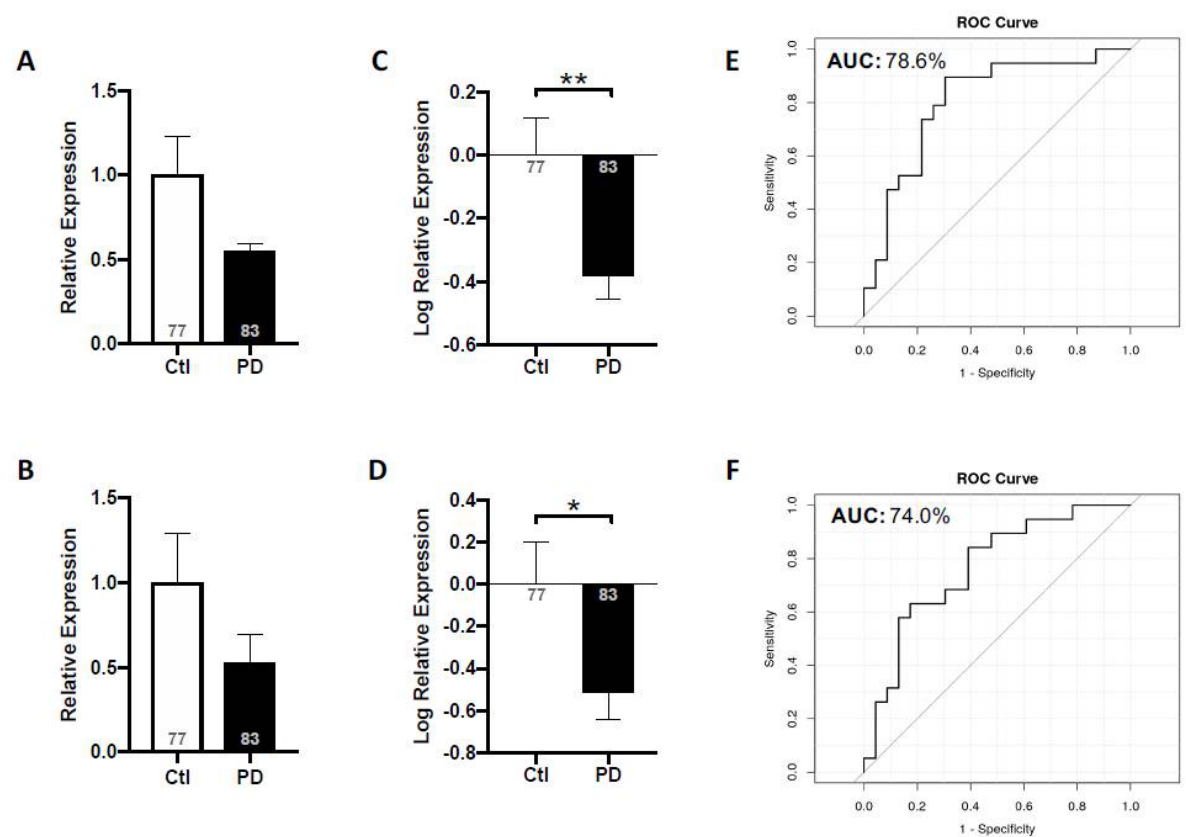
Figure 4. Salivary miR-153 and miR-223 expression levels in idiopathic PD subjects relative to non- neurological controls. Mean expression levels of miR-153 ( A ) and miR-223 ( B ) were determined by RT-qPCR and analyzed using the ∆∆ Ct method relative to internal and endogenous controls. Data was normalized via log-transformation and reported for miR-153 ( C ) and miR-223 ( D ). ROC curves were estimated for miR-153 ( E ) and miR-223 ( F ), with area under the curve indicated. Values shown within bars denote number of subjects. N = 77–83; * p < 0.05; ** p < 0.01. (From [19], with